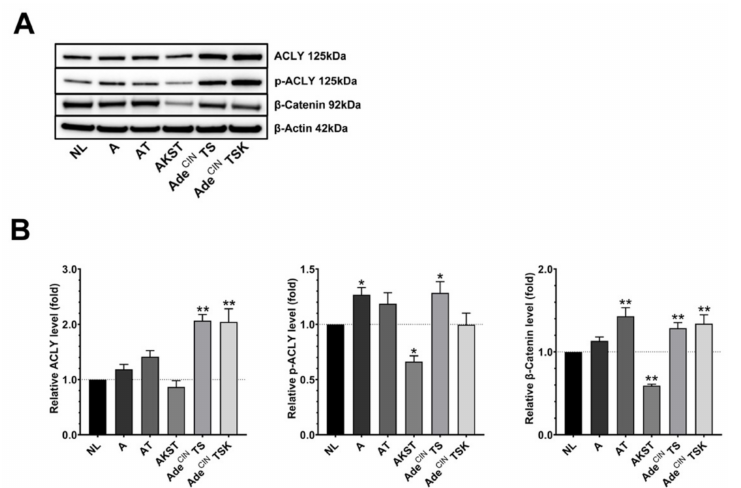
Figure 3. Upregulation of the Wnt/ β -catenin pathway occurs during the accumulation of ‘driver’ pathway mutations in human intestinal epithelial cell organoids. ( A , B ) Western blot analysis of ACLY, p-ACLY and β -Catenin in NL, A, AT, AKST, Ade CIN TS and Ade CIN TSK organoids after 7 days in culture. Data represent mean ± SEM of at least 4 independent experiments. * p < 0.05, ** p < 0.01 compared to